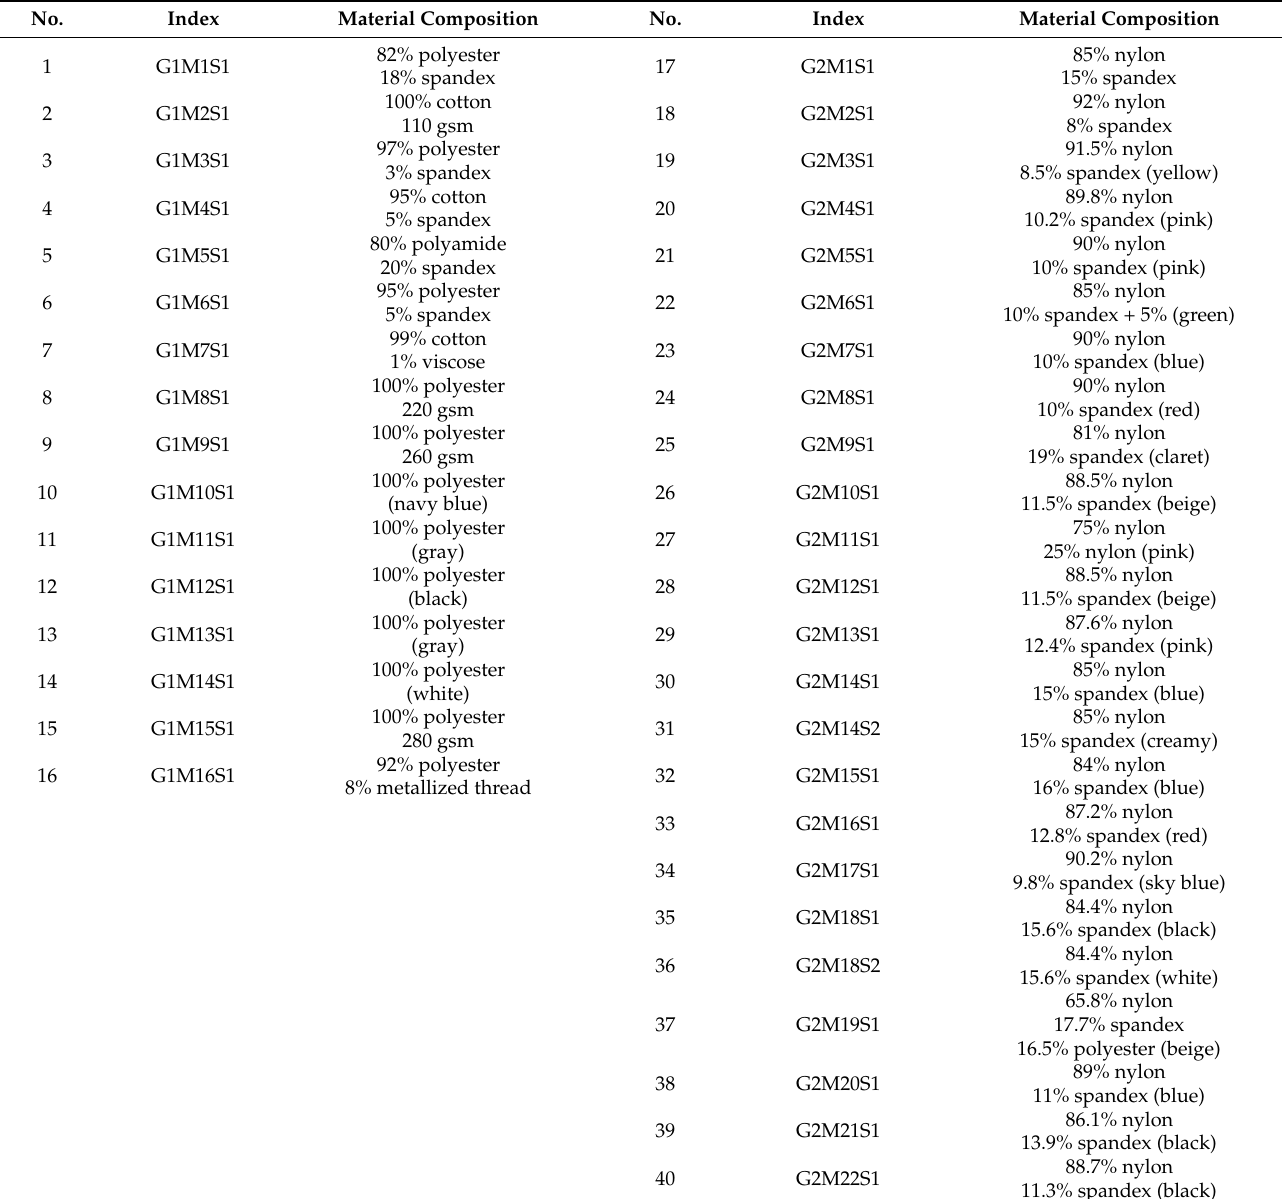
Table 2. Set of material samples for main